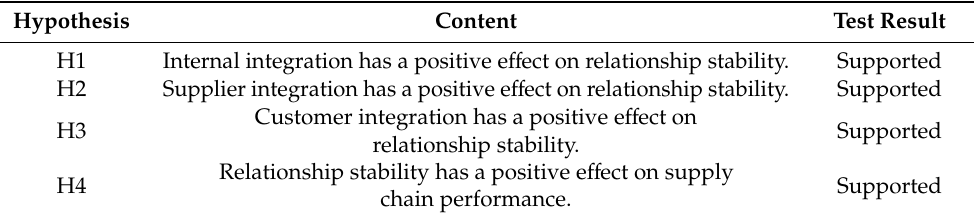
Figure 2. Research framework—relationship stability with customers. * p < 0.1; *** p < 0.01. Table 8. Results of the testing of